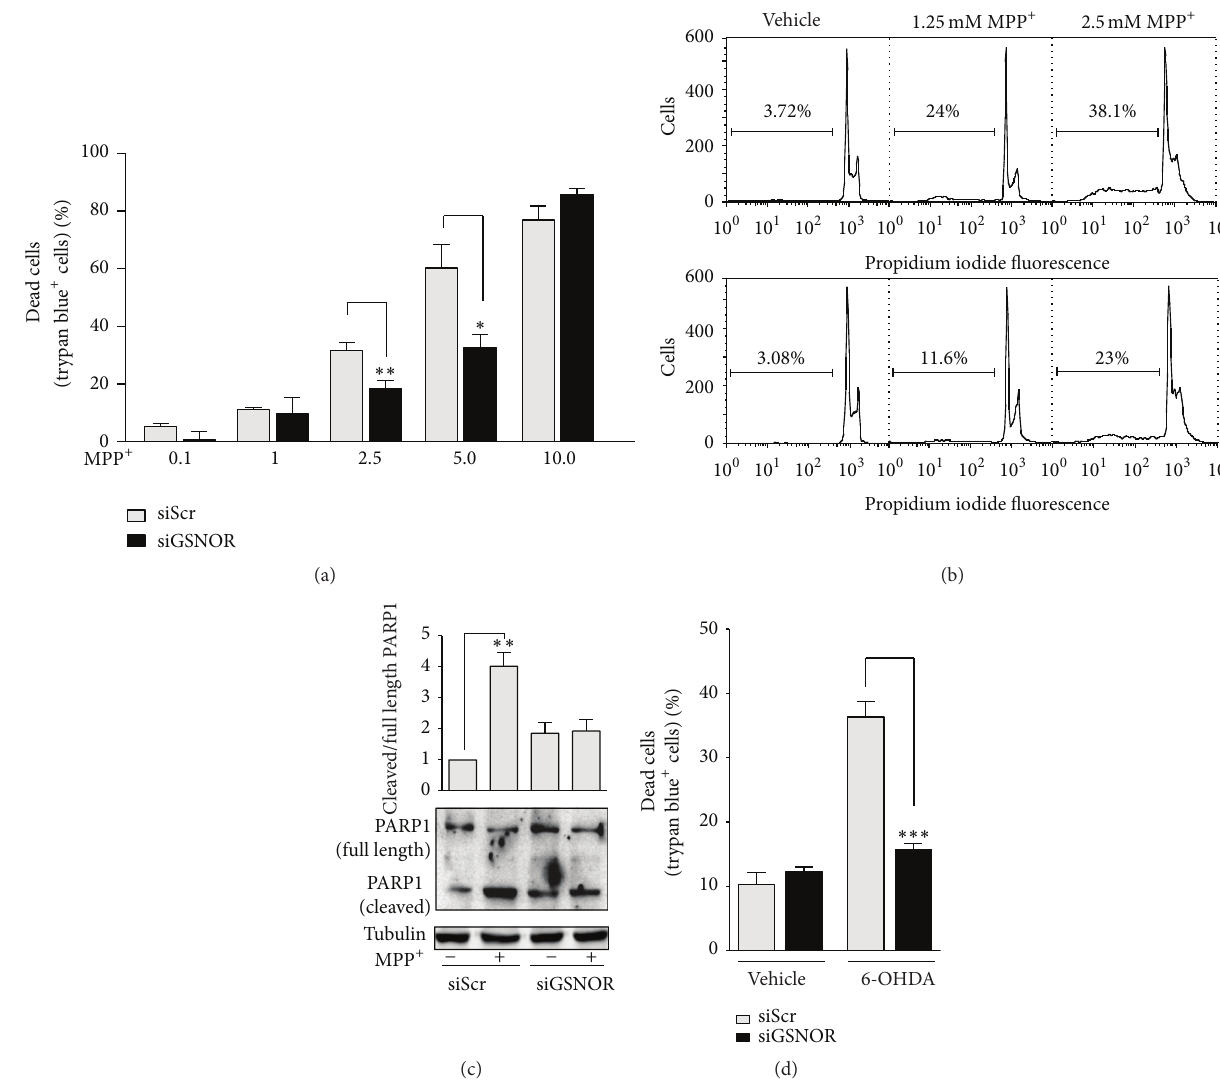
Figure 2: Cell death in siGSNOR cells. (a) Direct cell count upon Trypan blue staining of siScr and siGSNOR SH-SY5Y cells treated for 24 h with 0.1 to 10mM MPP + . (b) Cytofluorimetric histogram of siScr and siGSNOR SH-SY5Y cells treated for 24h with 1.25 or 2.5 mM MPP + upon propidium iodide staining percentage of subG1 (apoptotic) population is shown. (c) Western blotting of PARP1 in total cell lysates of siScr and siGSNOR SH-SY5Y cells treated for 24h with or without 2.5 mM MPP + . Densitometric analyses reporting the ratio cleaved: full length of PARP1 immunoreactive bands are shown on the top. (d) Direct cell count upon Trypan blue staining of siScr and siGSNOR SH- SY5Y cells treated for 24 h with 50 𝜇 M 6OHDA. Western blots shown are representative of at least 𝑛 = 3 independent experiments that gave similar results. Tubulin was selected as loading control. Graphs shown represent the mean of data ± SD of 𝑛 = 3 independent experiments, ∗ 𝑃 < 0. 05, ∗∗ 𝑃 < 0.01 , and ∗∗∗ 𝑃 < 0.001